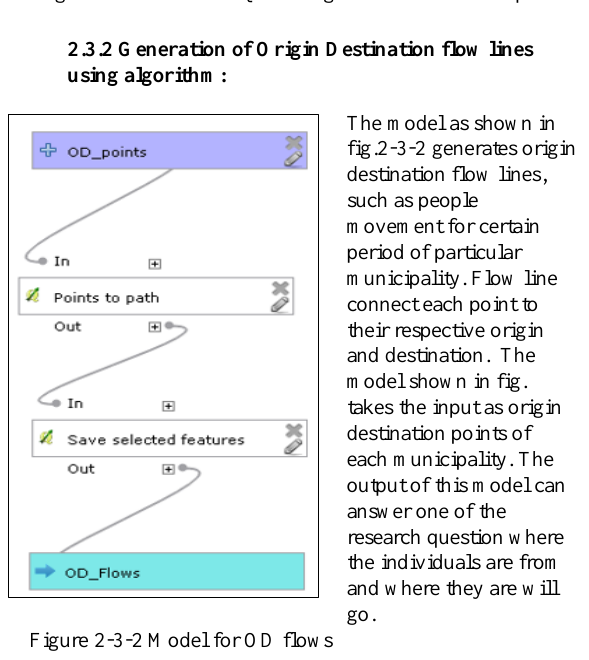
Figure 2-3-1 Model in QGIS to generate thematic maps